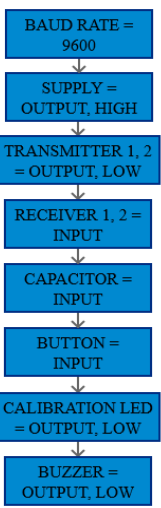
Figure 4. Block diagram of setup loop.